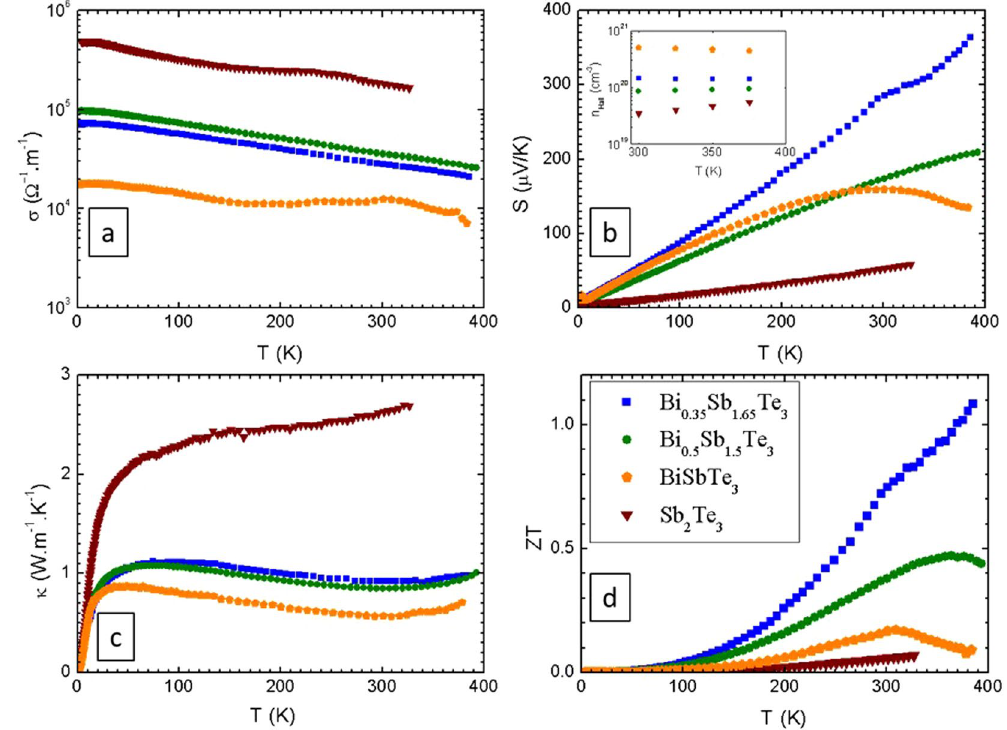
Figure 6. Temperature dependent electronic and thermal transport properties of Bi 2 − x Sb x Te 3 : ( a ) electrical conductivity, ( b ) Seebeck coefficient, (inset) charge carrier density from Hall-effect, ( c ) thermal conductivity, and ( d ) ZT figure of merit reaching 1.1 for the nominal composition Bi 0.35 Sb 1.65 Te 3